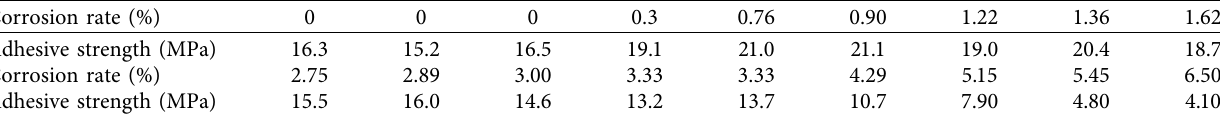
Table 1: Relationship between corrosion rate and adhesive